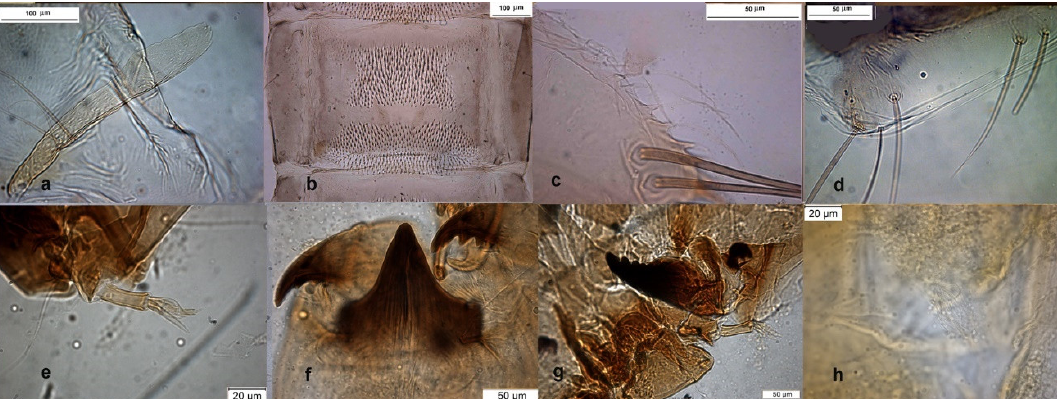
Figure 11. Morphological characters of O.S. ruffoi pupal exuviae: ( a ) thoracic horn, ( b ) tergite IV; ( c ) taeniate extensions;